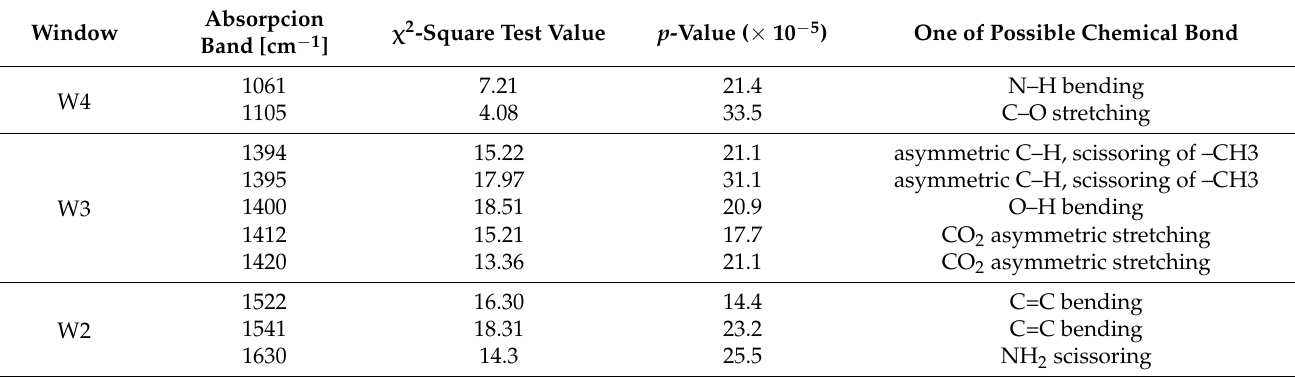
Table 4. Best predictors for H. pylori